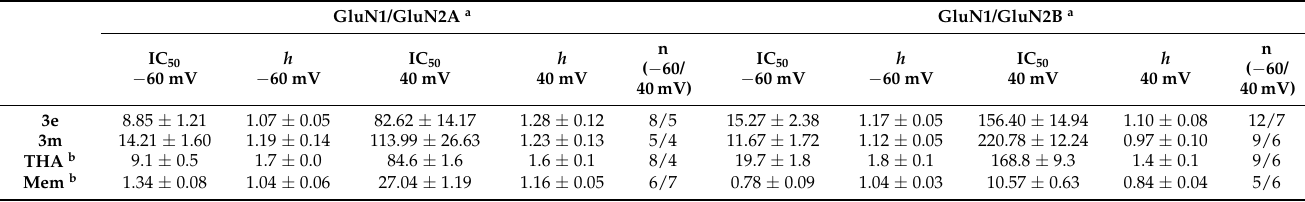
Table 4. The activity of derivatives 3e and 3m at the N -methyl- D -aspartate (NMDA) receptors at different membrane potentials compared to THA and memantine (Mem).